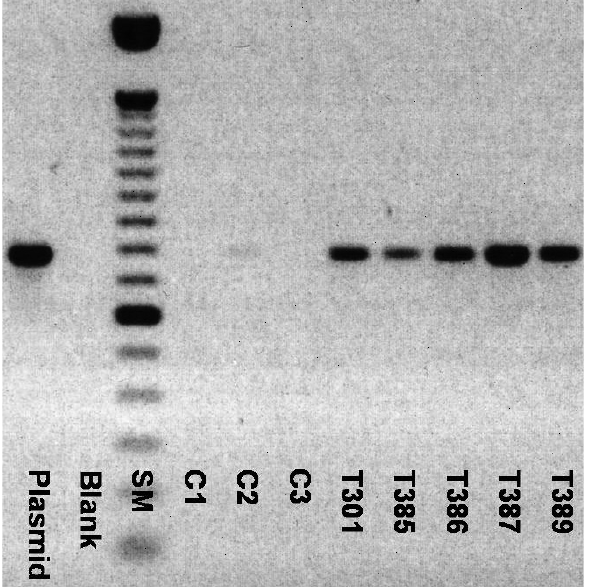
Figure 1 - Detection of nptII mRNA transcripts by RT-PCR. SM (size marker) – 100 bp DNA ladder, Blank – H 2 O sample, C1 – non-transgenic Pinova, C2 and C3 – non-transgenic plants of two other apple cultivars, T301-T389 – Nag+Endo transgenic lines of the apple cultivar Pinova.